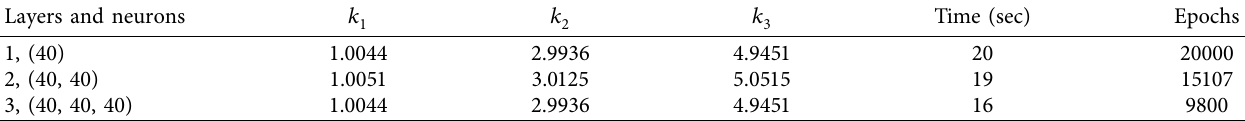
Table 6: Comparison of shallow vs. deep layers for Example 2.